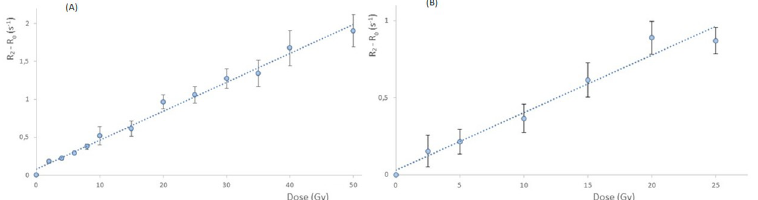
Fig 3. Gel dose response. (A) Measurement at low energy for 12 irradiation dose levels (2, 4, 6, 8, 10, 15, 20, 25, 30, 35, 40 and 50 Gy). The equation of the linear regression (dotted line) is ¼ 0 : 0381 � Dose þ 0 : 0836 ð r 2 ¼ 0 : 9893 Þ . (B) Measurement at high energy for 6 irradiation dose levels (2.5, R 2 (cid:0) R 2 0 5, 10, 15, 20 and 25 Gy). The equation of the linear regression (dotted line) is ¼ 0 : 0372 � Dose þ 0 : 0326 ð r 2 ¼ 0 : 9662 Þ . R 2 (cid:0) R 2 0